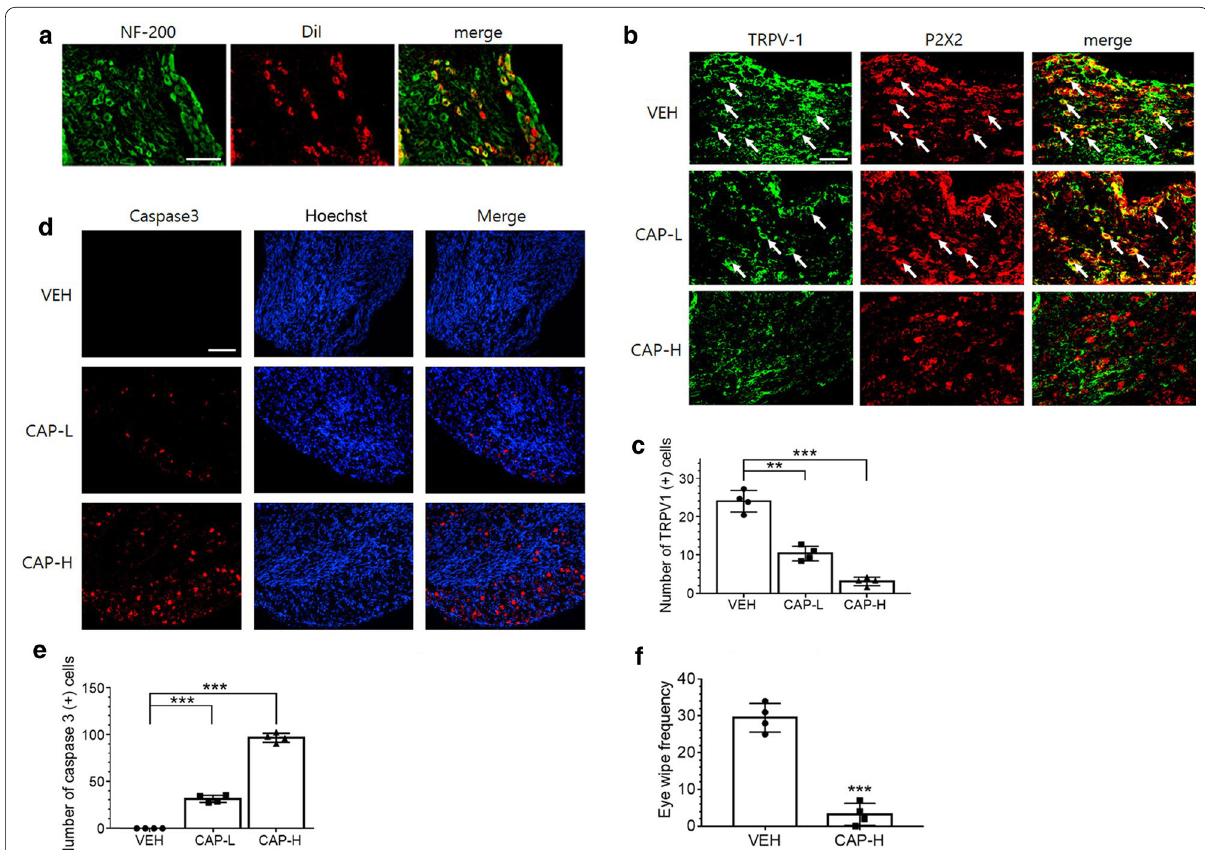
Fig. 6 Immunofluorescence identification of degenerating NG neurons in CAP‑treated animals. a Colocalization of DiI‑labeled neurons with NF‑200‑immunostained neurons in the NG. Seven days after DiI injection into the hepatic vagal branch in rats, NG was dissected and subjected to immunofluorescence staining for NF‑200. b – e Immunofluorescence staining of TRPV1 and P2X2 proteins in the NG. Three days after CAP injection with a total of 100 mg/kg (CAP‑L) or 200 mg/kg (CAP‑H), NG sections were prepared for immunofluorescence staining for TRPV1 and P2X2 receptor proteins ( b ) or for cleaved form of caspase 3 with Hoechst 33258 nuclear staining ( d ). The number of neurons labeled with TRPV1 and caspase 3 proteins were quantified and plotted in c and e , respectively. **p < 0.01, ***p < 0.001 (One way ANOVA with Tukey post hoc, n 4). Scale bars in a , b , = and d are 100 μm. f Eye wiping test in rats. Eye wipe frequency during 5 min period was measured and compared between CAP‑ and VEH‑injected animals. ***p < 0.001, t 10.74 (unpaired t‑test, n = =